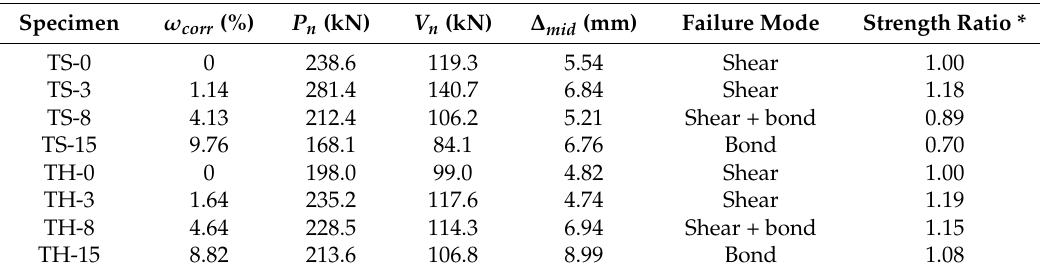
Table 3. Summary of shear test